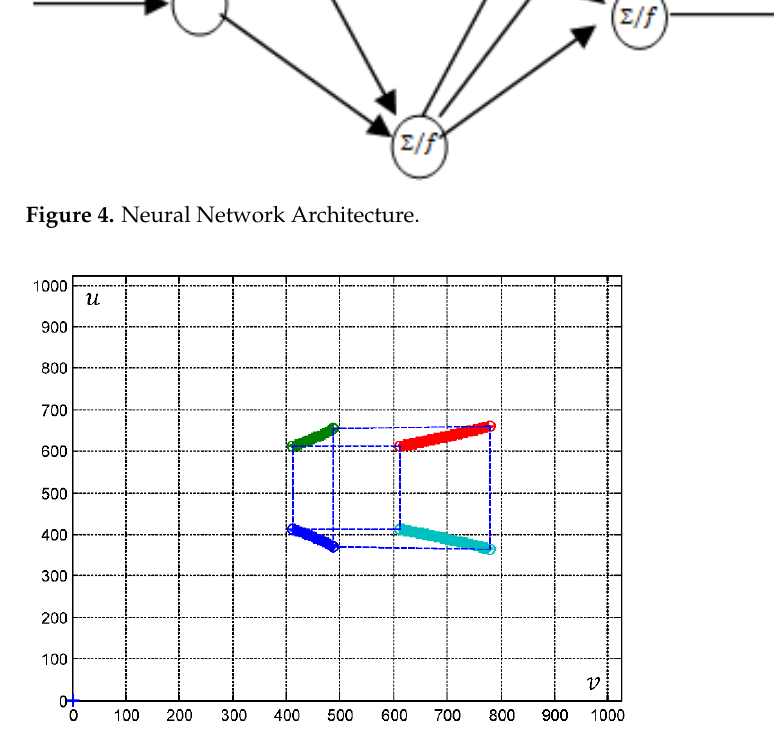
Figure 5. Translation + Rotation in image space.